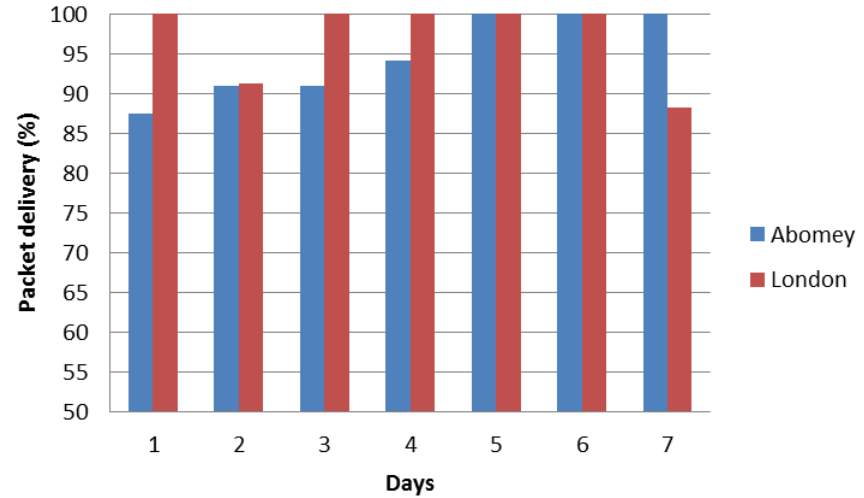
Figure 6. Daily averaged delivery rate of the communication system over a